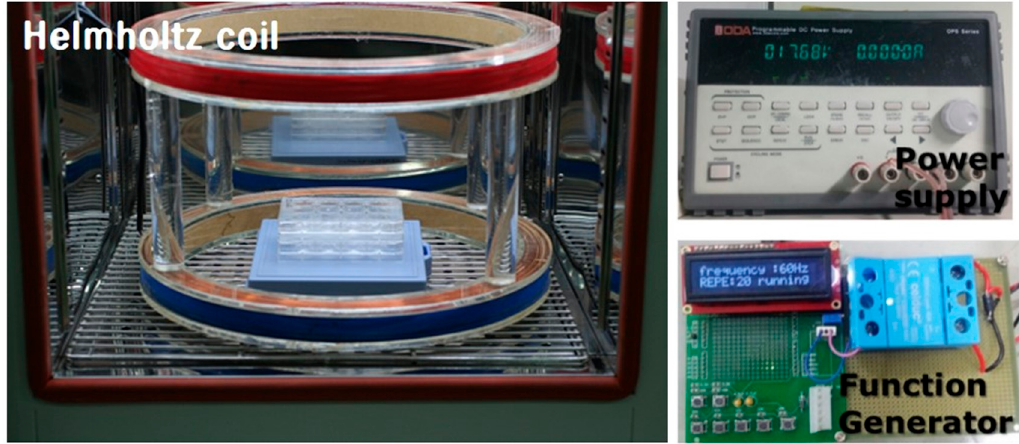
Figure 1. Photograph of the electromagnetic field (EMF) device. Pulsed EMF was generated using a pair of Helmholtz coils of 40 cm diameter and 15 cm separation.